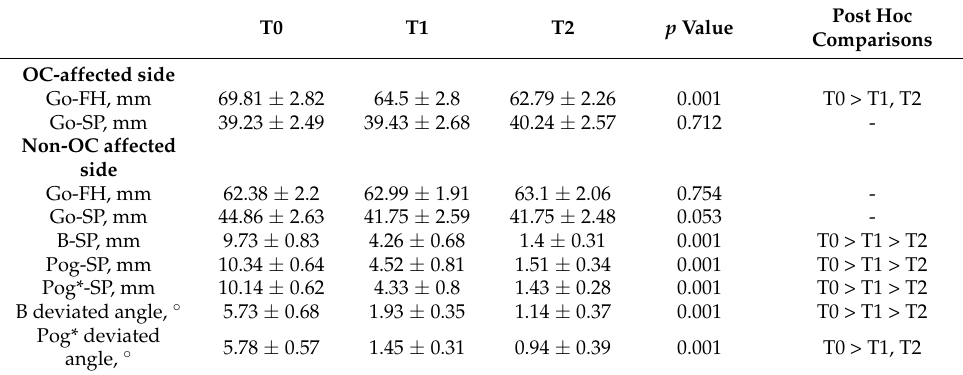
Table 4. Comparisons of 3D cephalometric measurements at T0, T1, and T2.